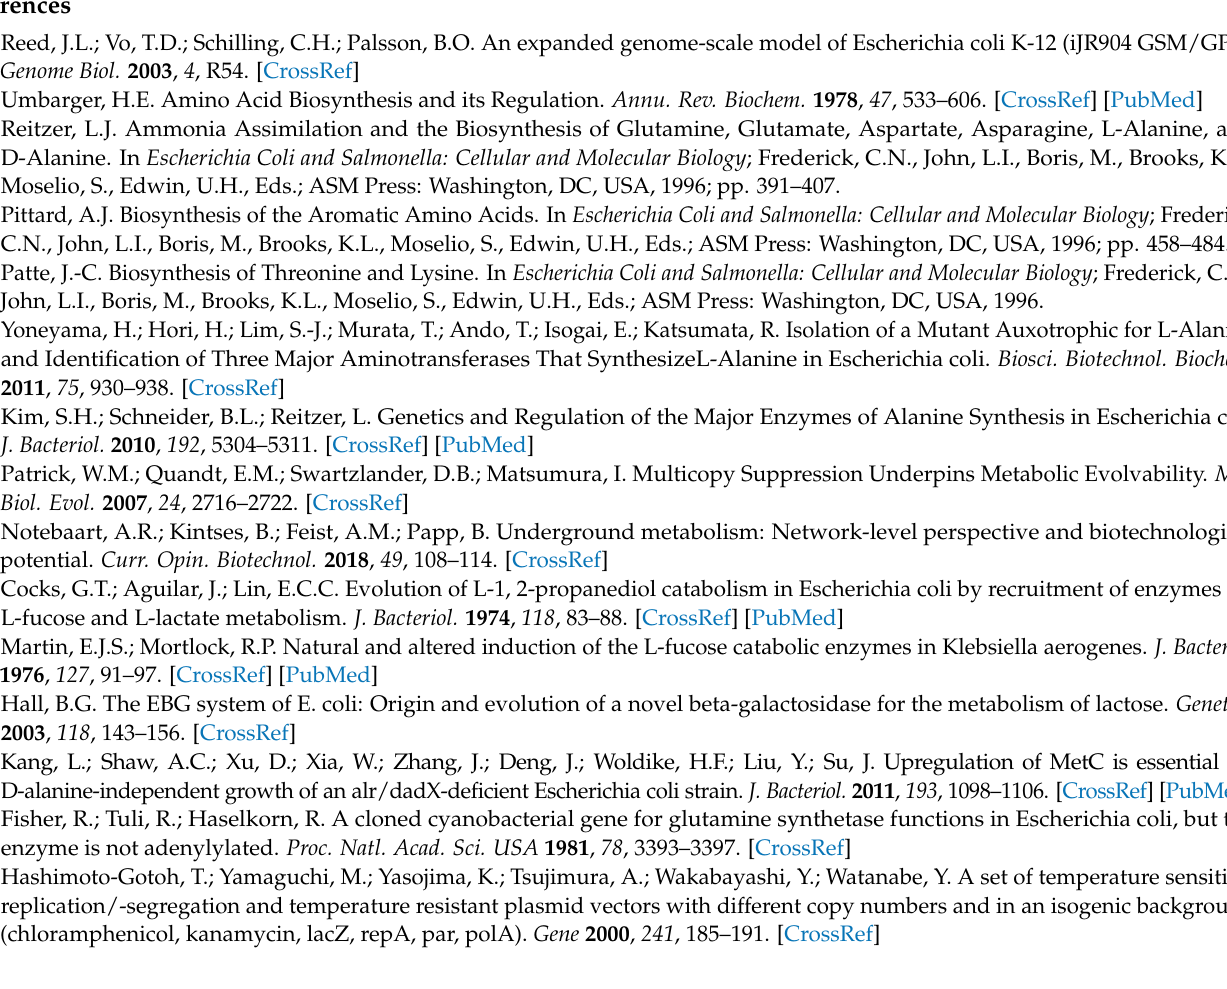
7/9/3/472/s1, Figure S1: Emergence of L-alanine prototrophic mutants from L-alanine auxotroph HYE032; Figure S2: Growth of L-alanine prototrophic suppressor mutants obtained on minimal agar medium; Figure S3: Effect of L-glutamic acid on the growth of L-alanine auxotroph HYE032; Table S1: Primers used for sequencing of candidate genes; Table S2: Summary of suppressor mutants in terms of numbers of genes harboring mutation(s); Table S3: Summary of suppressor mutants in terms of genes